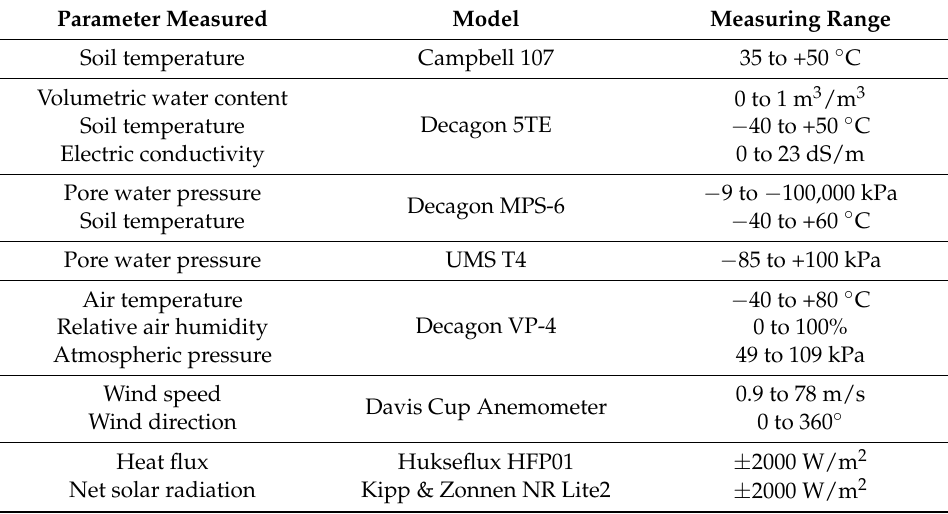
Table 1. Characteristics of the sensors installed in the vertical slope